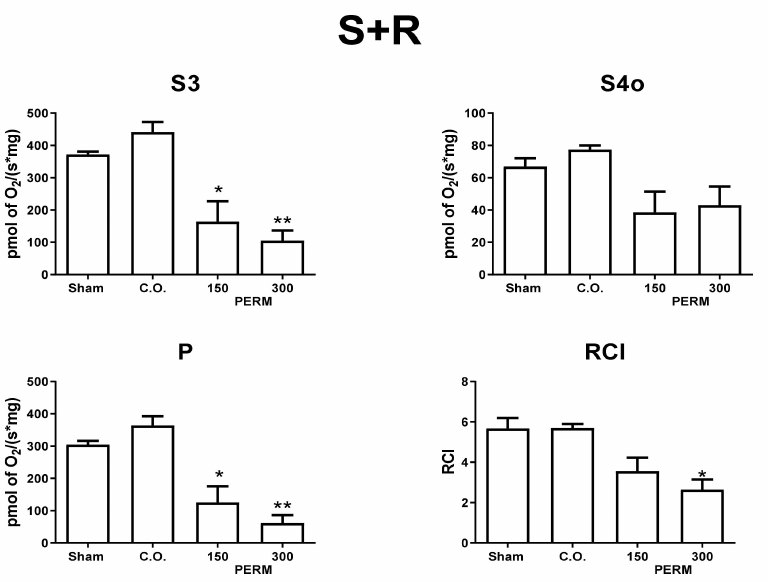
Figure 8. Respiratory parameters in CII-linked respiration. Mitochondrial respiratory parameters: state 3 (S3), state 4 induced by oligomycin (S4o), respiratory control index (RCI) and OXPHOS associated respiration (P) using succinate plus rotenone (S + R) as substrates. Data are mean ± SE, n = 5–6. * p < 0.05 vs. sham group, ** p < 0.01 vs. sham